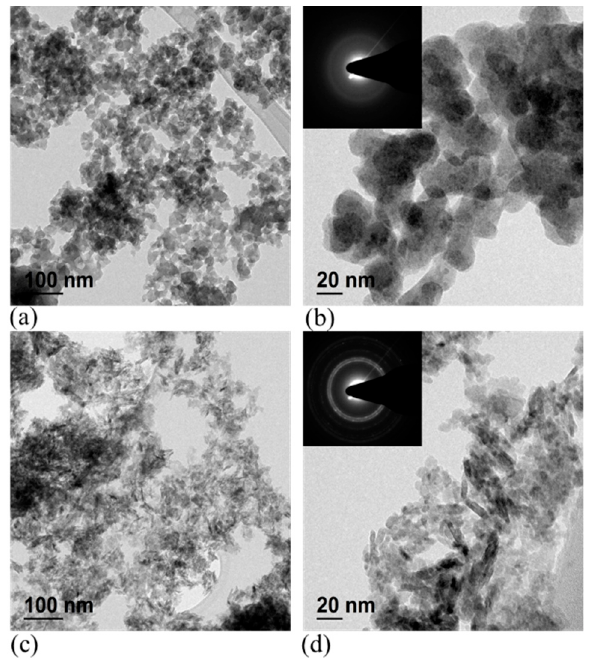
Figure 6. Transmission electron microscope (TEM) image of ( a , b ) the precipitated Cu using electro-generated NaOCl and ( c , d ) using reagent-grade NaOCl. The insets in ( b ) and ( d ) are the corresponding selected area electron diffraction (SAED) patterns.